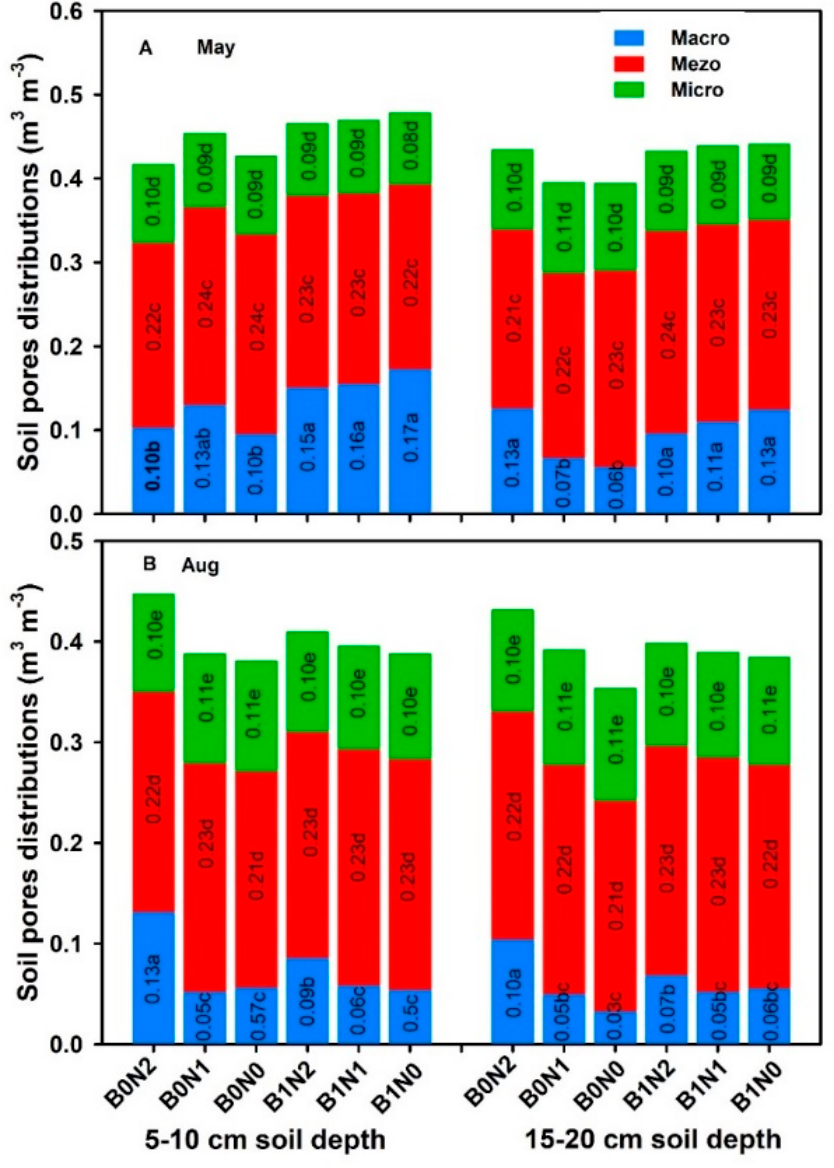
Figure 4. Effect of different treatments on pore size distribution (macropores, mesopores, and micropores) ( A ) in May, at 5–10 cm and 15–20 cm depths, ( B ) in August at 5–10 cm and 15–20 cm depths for B0N0 (without biochar or N fertilization); B0N1 (without biochar and with 160 kg·ha − 1 N); B0N2 (without biochar and with 120 kg·ha − 1 N); B1N0 (biochar 25 t·ha25 t·ha − 1 only); B1N1 (biochar 25 t·ha − 1 and 160 kg·ha − 1 N); and B1N2 (biochar 25 t·ha − 1 and 120 kg·ha − 1 N The letters a–e indicate statistically significant difference at p < 0.05.